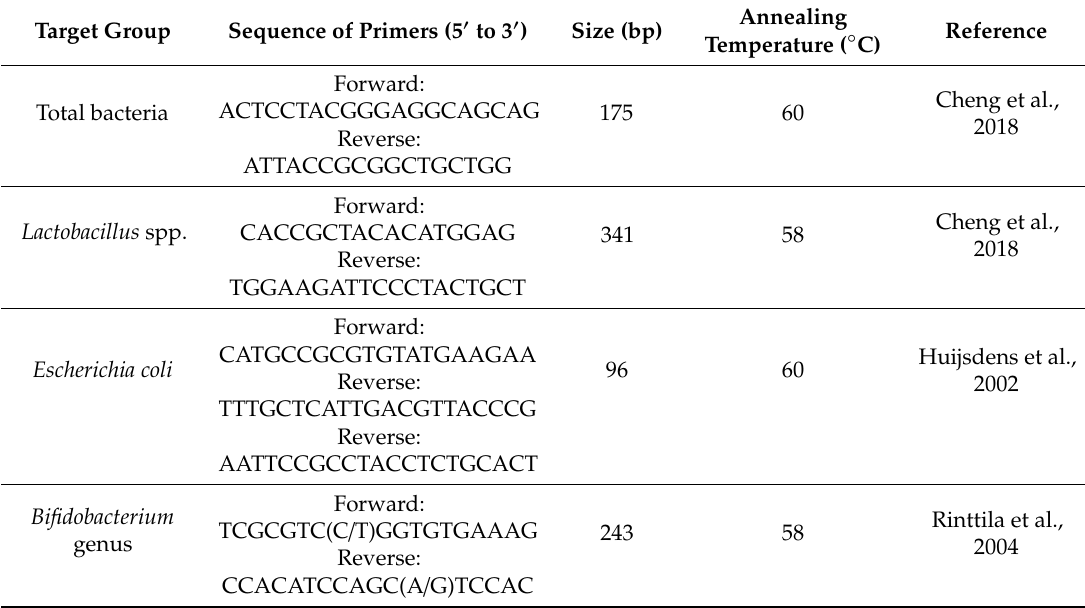
Table 1. Primers used for absolute quantitative real-time polymerase chain reaction (PCR) in this study. Target